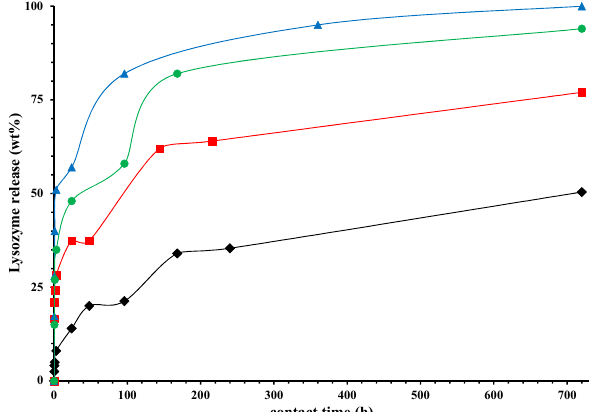
Figure 7. Lysozyme released (wt %), as function of time (hours) for: PCL/10%HNTs ‐ lysozyme ( ⧫ ), a sample drawn at λ = 3 ( ■ ), a sample drawn at λ = 4 ( ● ), and a sample drawn at λ = 5 ( ▲ ).